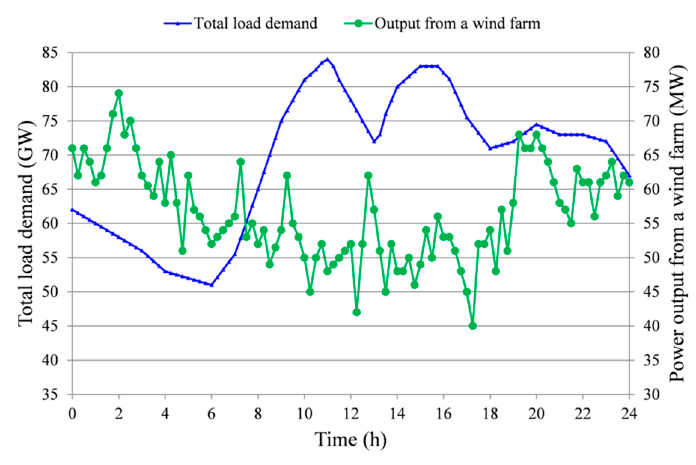
Figure 7. Typical daily load demand and power output from a wind farm in Guangdong.